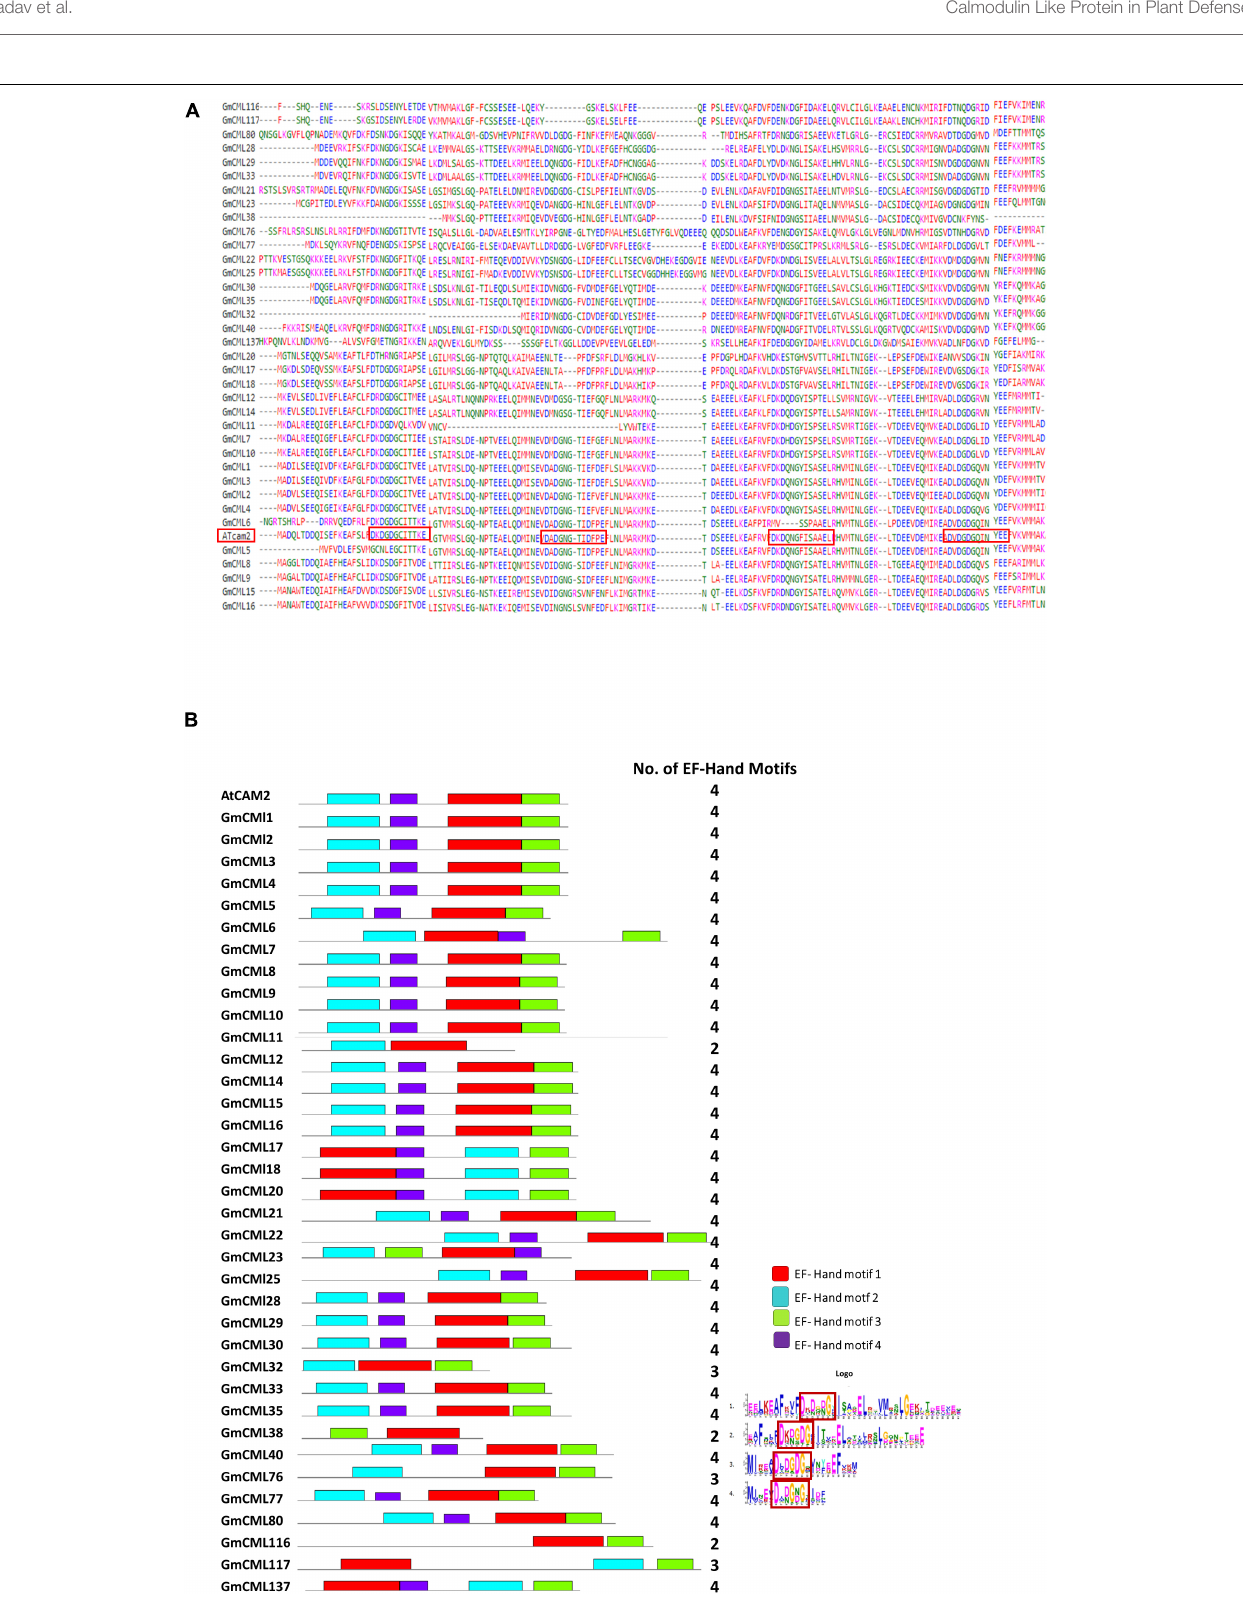
Frontiers in Plant Science |